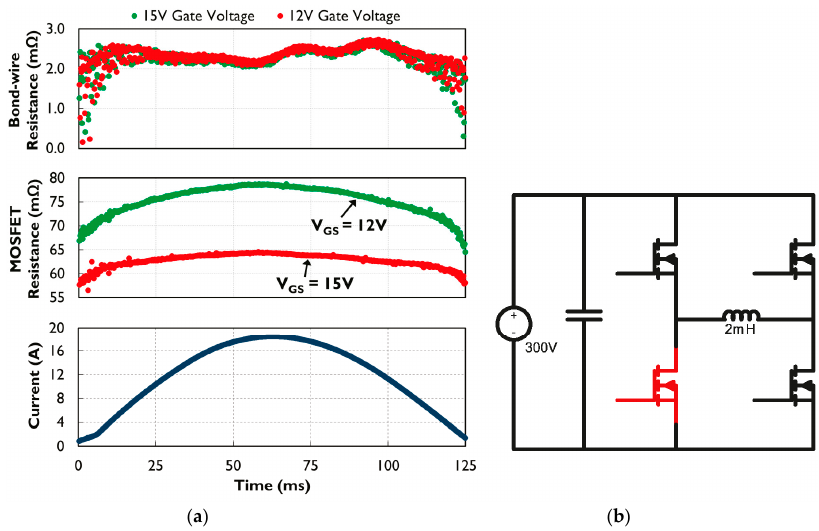
Figure 4. ( a ) MOSFET and bond-wire resistances at different gate voltages for one sinusoidal half-period in a single-phase inverter. MOSFET resistance is calculated using V DS , while bond-wire resistance is calculated using V SS ; ( b ) H-bridge inverter schematic (red MOSFET is the Device under Test).